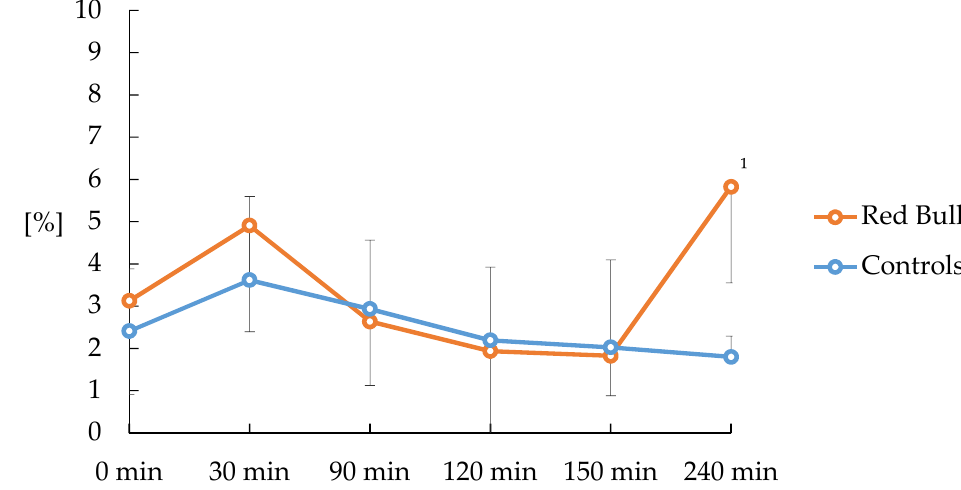
Figure 2. Course of shunt fraction after consumption of Red Bull or placebo in normoxic and hypoxic piglets ( n = 16). 1 p < 0.05 versus control. Shunt reflects unventilated lung units. Normoxia (F i O 2 = 0.21) 0–120 min; Hypoxia (F i O 2 = 0.13) 120–240 min. Piglets ( n = 8) received 10 mL / kg Red Bull at 0 min and